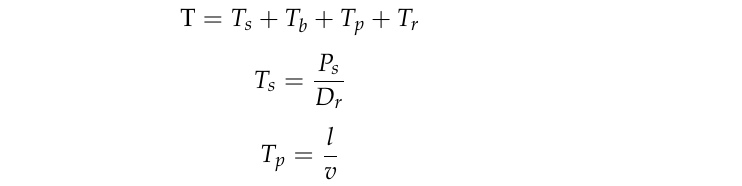
Figure 4. Control block for switching of TSC-TCR.